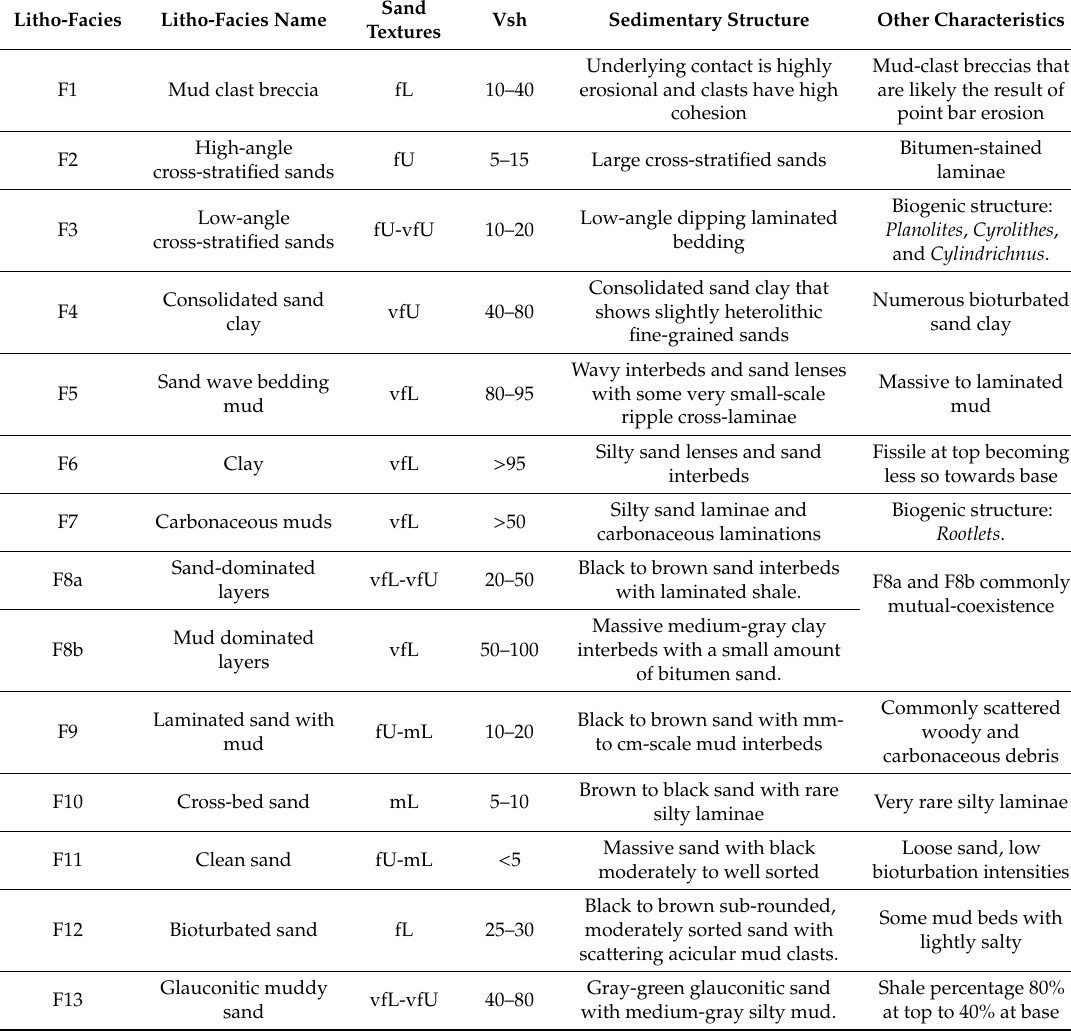
Table 1. Summary of identified facies